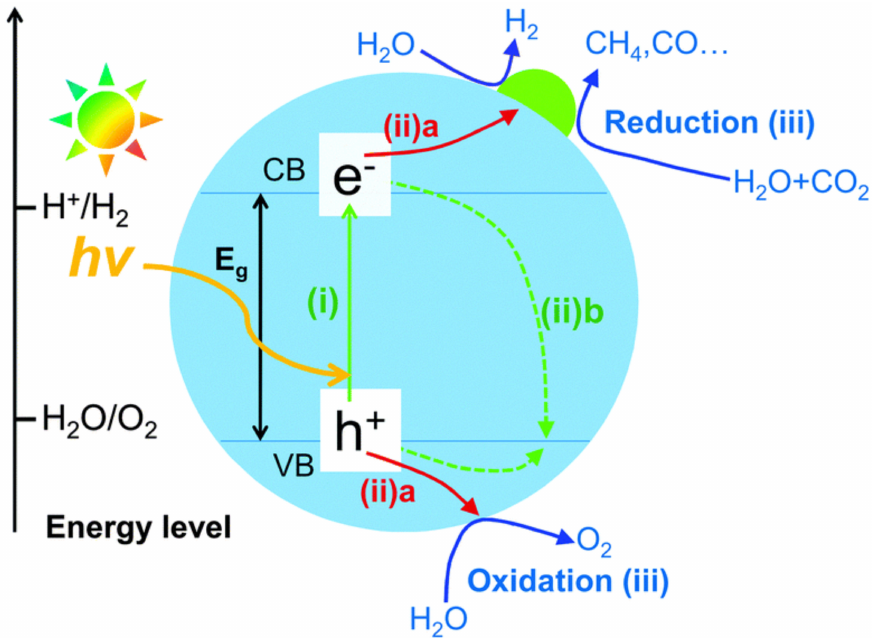
Figure 5. Schematic illustration of the basic mechanism of photocatalytic reduction of CO 2 with H 2 O on a semiconductor photocatalyst. Adapted and reprinted with permissions from [14], Copyright (2016) Royal Society of Chemistry